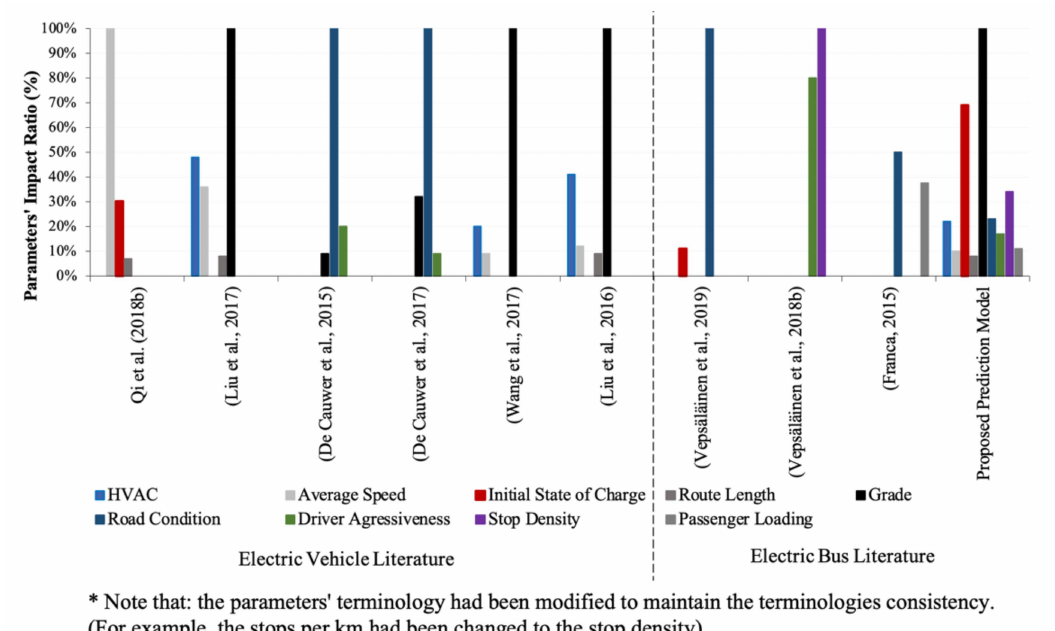
Figure 10. The relative weight (normalized per study) of significant parameters impacting electric powertrains energy